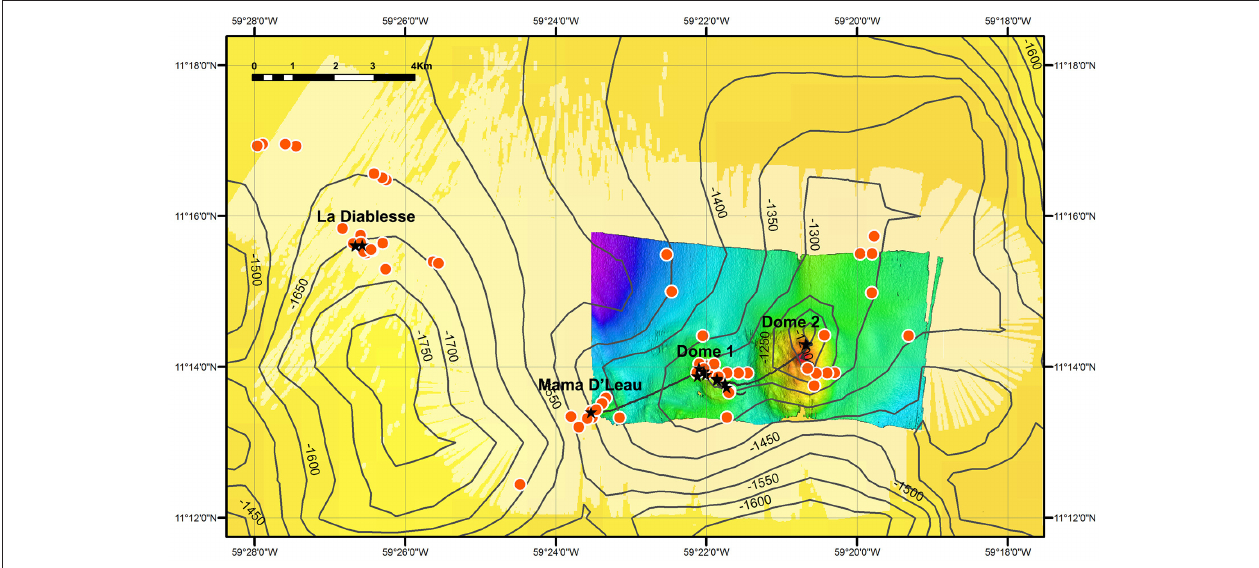
FIGURE 6 | Locations of prospective methane-seep sites. Red dots are the locations of methane bubbles emitted from the seafloor (indicative of seepage) that were identified from water column data using the shipboard EM302 multibeam, while black stars are locations of bubble streams visually confirmed with the ROV Hercules . Gridded bathymetric data provided by the General Bathymetric Chart of the Oceans (GEBCO) 30 arc-second grid (accessed via http://www.gebco.net/). Map and associated shapefiles created in ESRI ArcMap (version 10.3.1). The high-resolution central section was constructed from unpublished ship-based bathymetry data from the EV Nautilus . The entire light yellow area was surveyed with the ship-based multibeam but due to adverse surveying conditions, only the water column data were